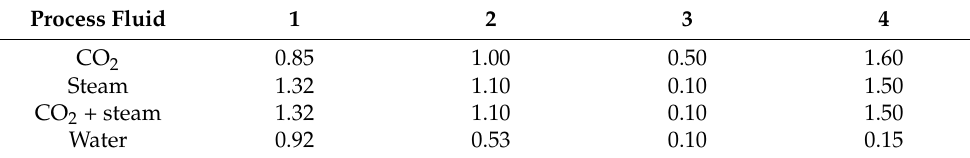
Table 8. Maximum errors of studied solutions at rated flow, %.